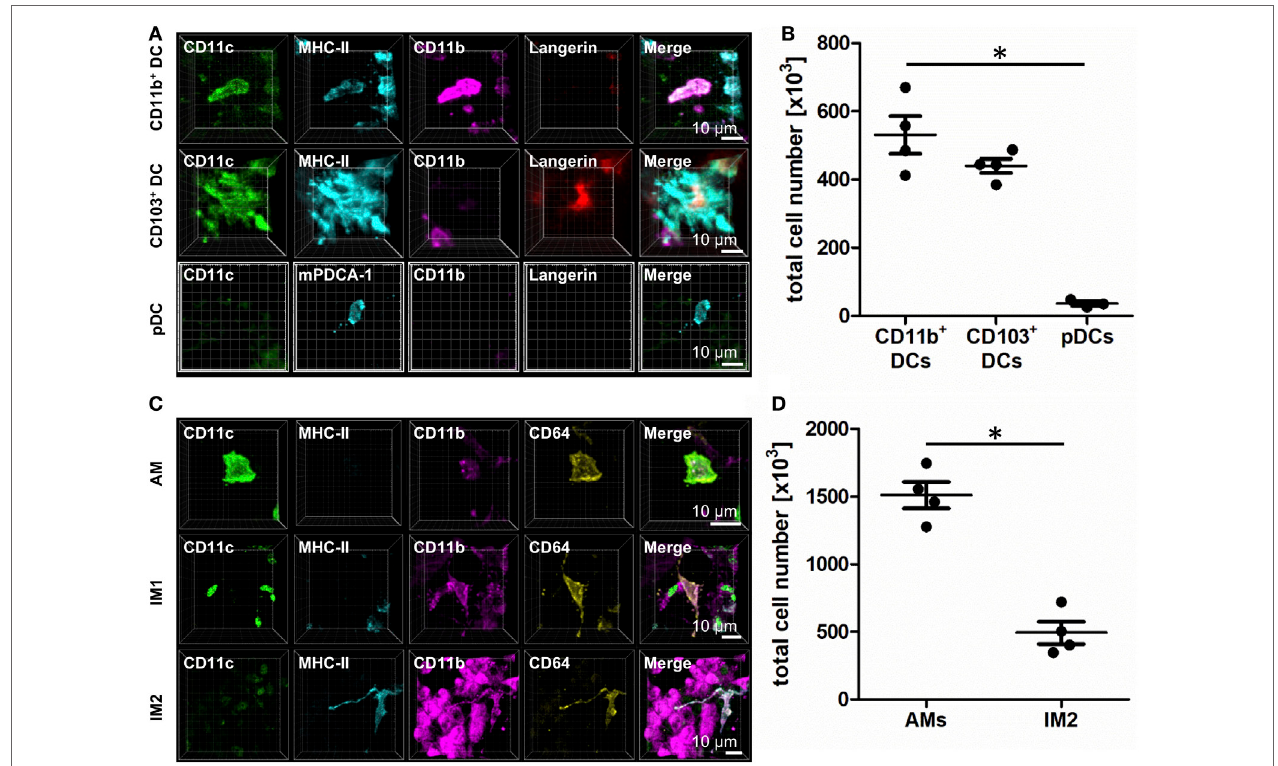
FigUre 1 | Identification of lung phagocyte subsets by immunohistochemistry (IHC). Precision cut lung slices (PCLS) (300 µm) from naive C57BL/6 mice were generated and stained with anti-CD11c, anti-MHC-II or anti-mPDCA-1, anti-CD11b, and anti-Langerin (a,B) or anti-CD64 ABs (c,D) . Stained slices were evaluated with confocal microscopy. IHC of CD11b + dendritic cells (DCs), CD103 + DCs, and plasmacytoid DCs (pDCs) (a) or alveolar macrophages (AMs), interstitial macrophages (IM)1, and IM2 (c) . Single-color and merged color display with CD11c (green), MHC-II or mPDCA-1 (turquois), CD11b (purple), and Langerin (red) or CD64 (yellow). Data are representative of at least three independent experiments. Quantification of CD11b + DCs, CD103 + DCs, and pDCs (B) and AMs and IM2 (D) in total lungs. Lines indicate mean ± SEM. Differences between groups were tested by Kruskal–Wallis test (b) or Mann–Whitney U -test (d) for significance; * p < 0.05.